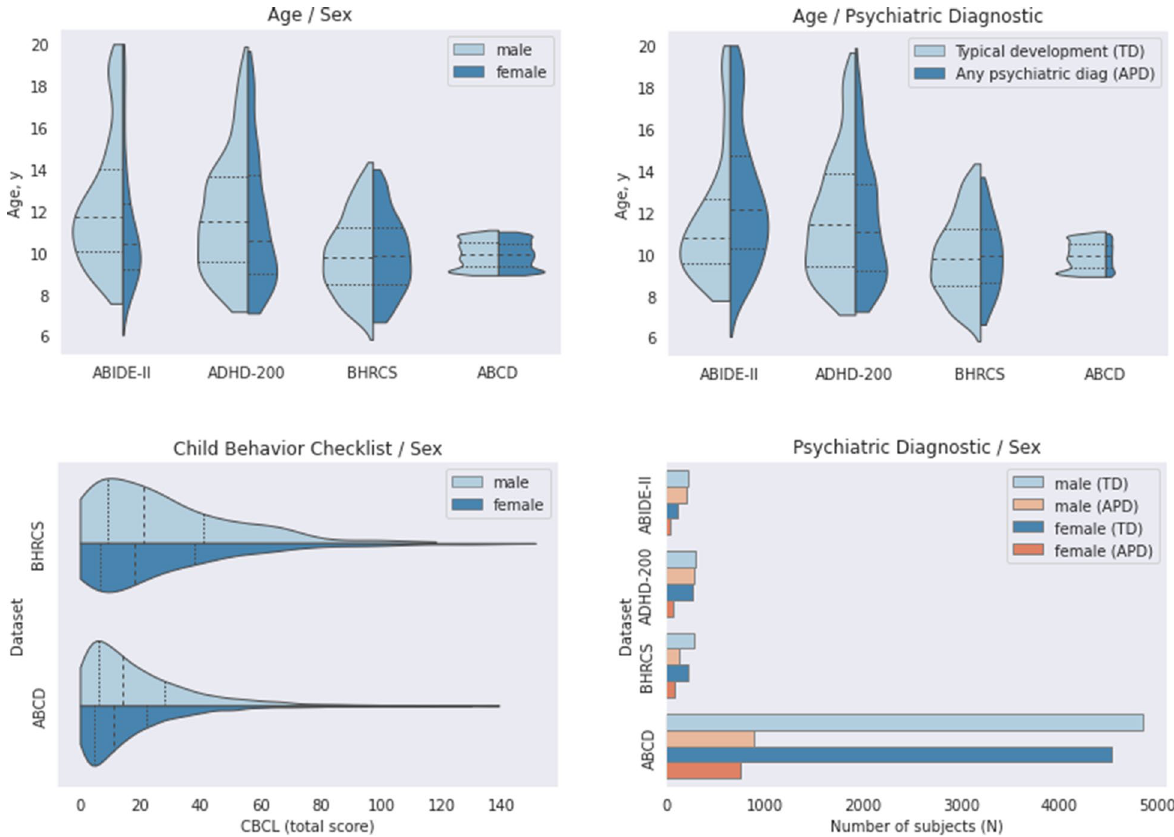
Figure 1. Demographic and phenotypic distribution of subjects. In violin plots, the dotted lines show the quartiles. Ages are presented in years, and CBCL in raw values. Acronyms: TD = typical development, APD = any psychiatric diagnostic, and CBCL = child behavior checklist. APD indicates autism spectrum disorder for ABIDE-II, attention deficit hyperactivity disorder for ADHD-200, and any psychiatric diagnostic (from DSM-IV or DSM-V) for BHRCS and ABCD,